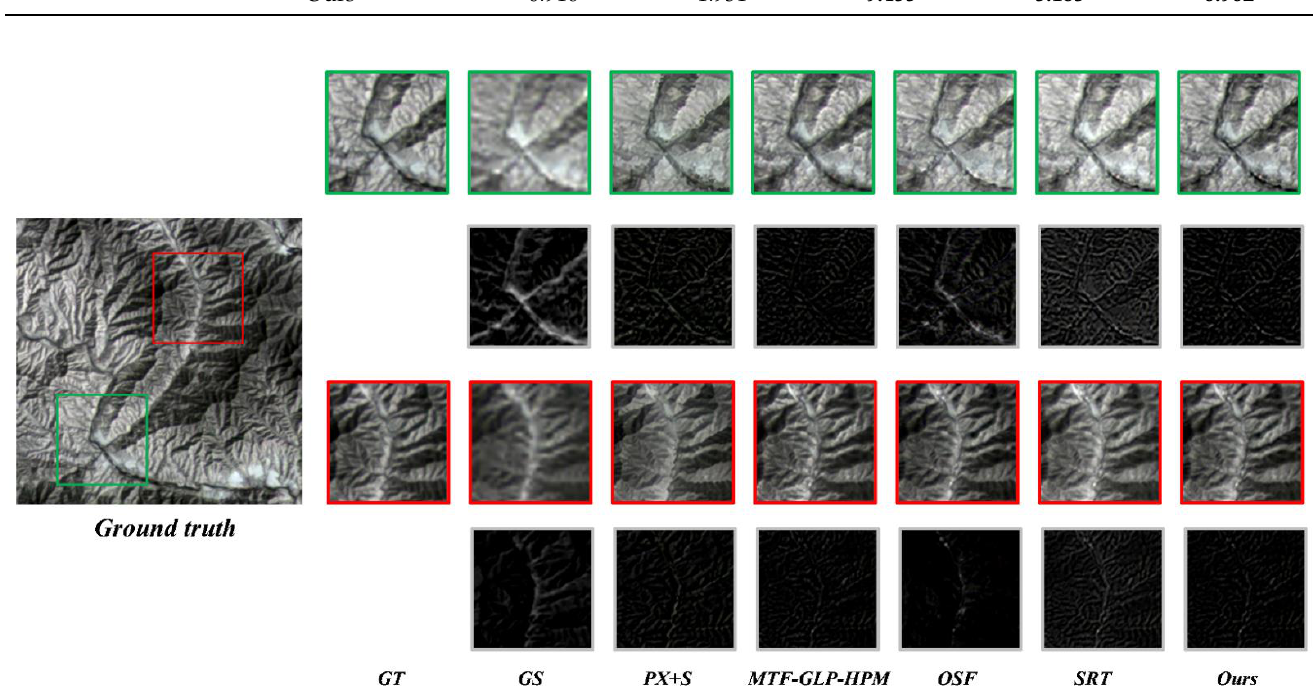
Figure 4. Comparison of fusion results of different algorithms on simulation data (the original image was taken in Beijing on 3 May 2022; scene: airport).